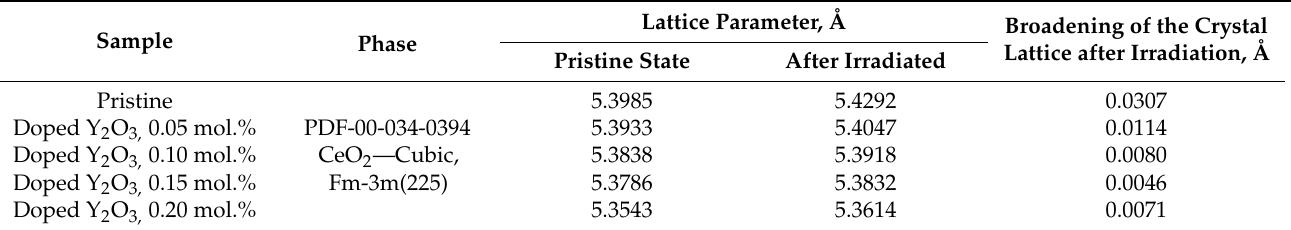
Figure 4. X ‐ ray diffraction results of the studied samples depending on the concentration of Y 2 O 3 dopant. Table 1. Data of structural